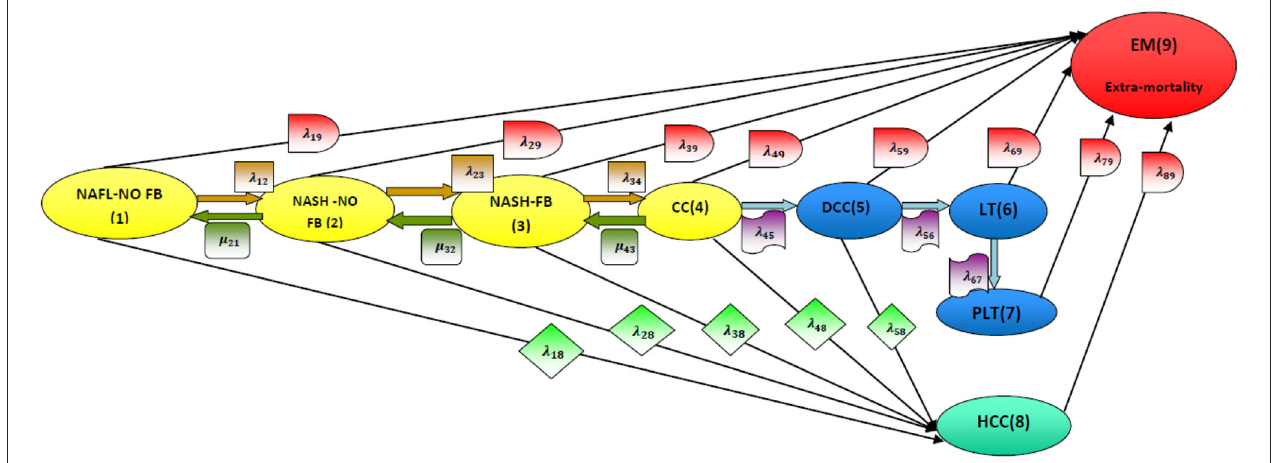
FIGURE 2 | Disease model structure. NAFL-NO FB, non-alcoholic fatty liver with no fibrosis (stage 1); NASH-NO FB, non-alcoholic steatohepatitis with no fibrosis (stage 2); NASH-FB, non-alcoholic steatohepatitis with fibrosis (stage 3); CC, compensated cirrhosis (stage 4); DCC, decompensated cirrhosis (stage 5); LT, liver transplant (stage 6); PLT, post liver transplant (stage 7); HCC, hepatocellular carcinoma (stage 8); EM, extramortality (stage 9). [